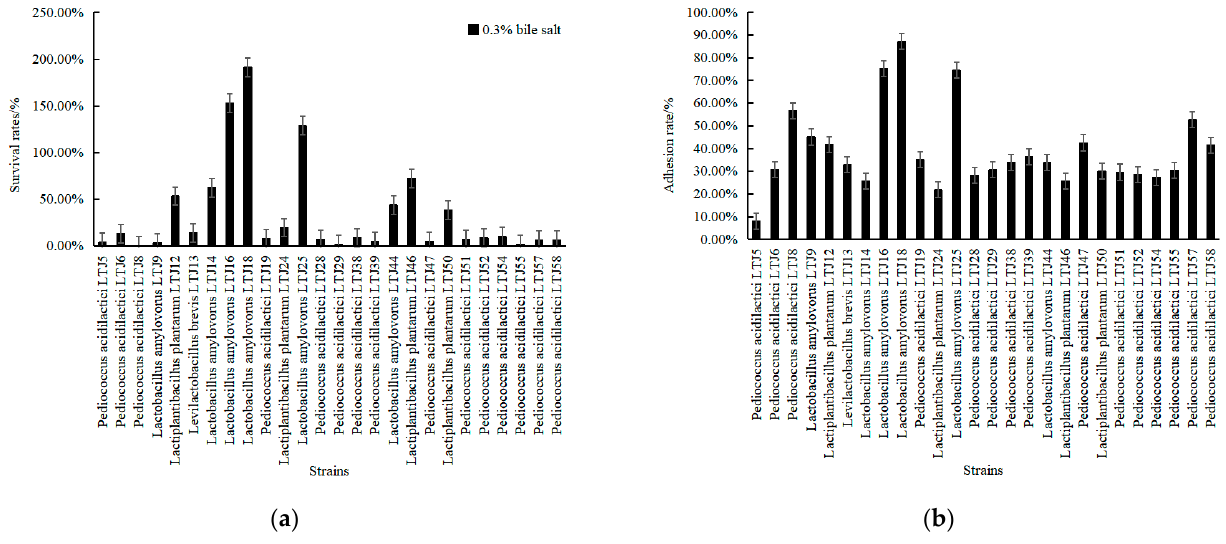
Figure 6. Determination of difference in ( a ) bile salt resistance and ( b ) adhesive ability to collagen of strains.